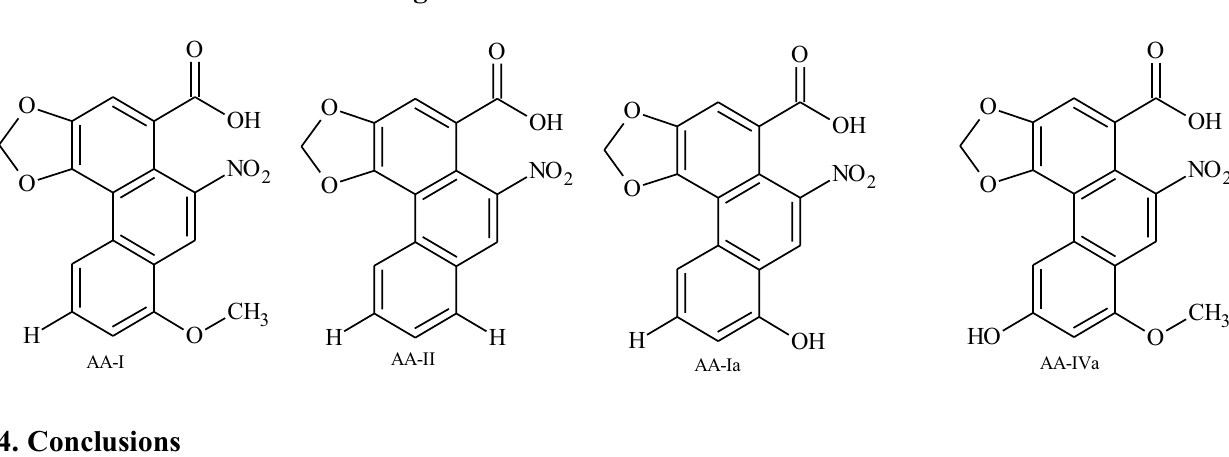
Figure 3. Aristolochic acid